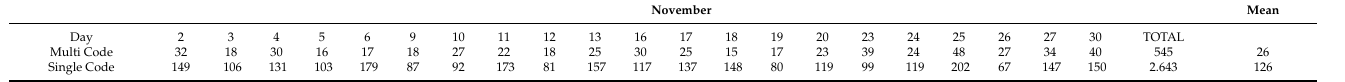
Table 4. Daily distribution of pallets, by type, received during November